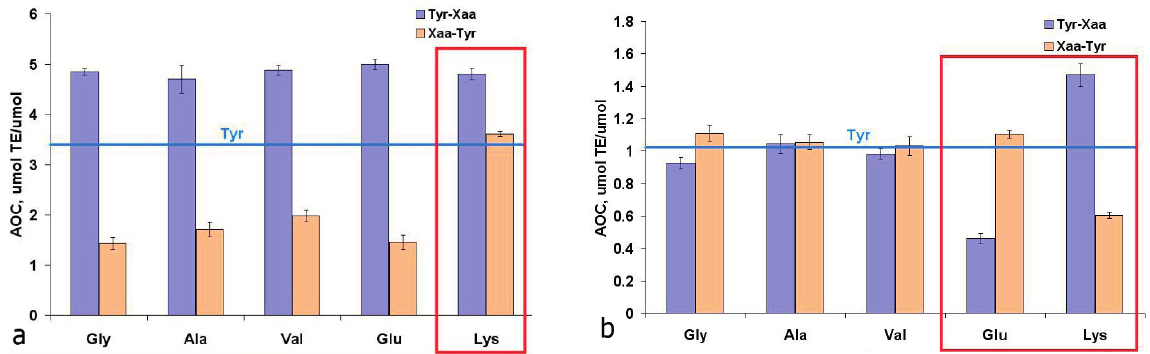
Figure 2. Antioxidant capacity of tyrosine dipeptides in TEAC ( a ) and ORAC ( b ) assays. The red squares indicate peculiar behavior of dipeptides with ionogenic side